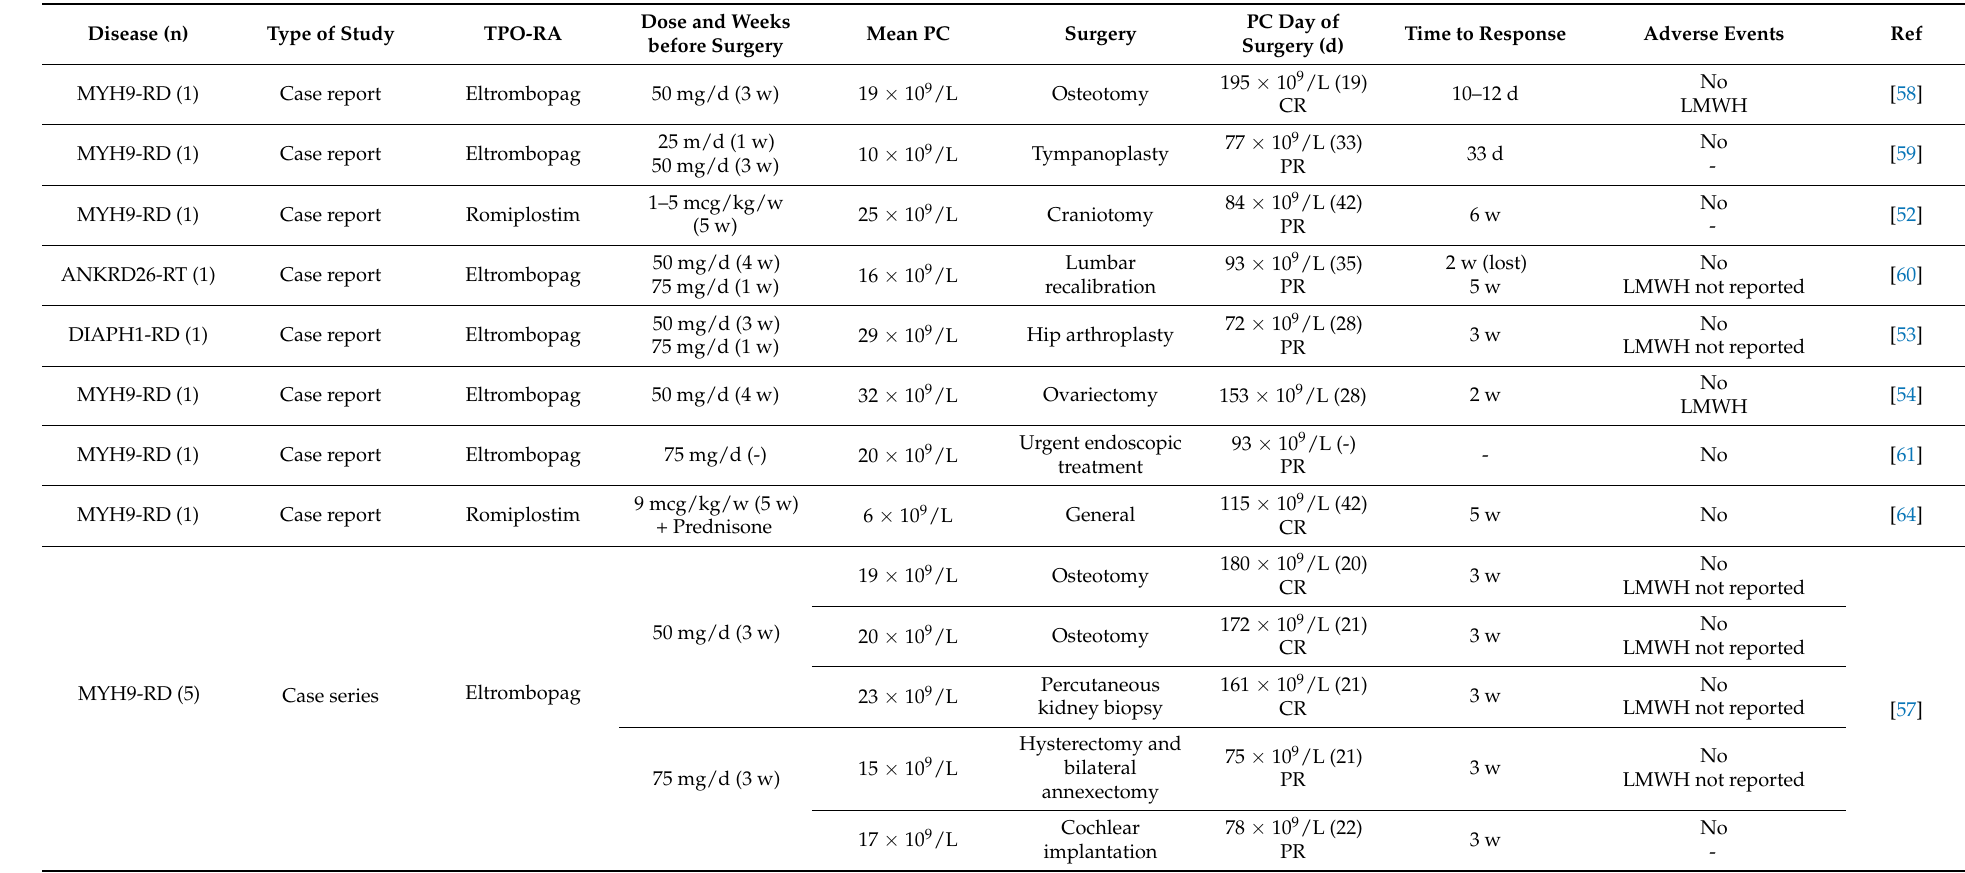
Table 3. Previous experience with the use of TPO-RA to prepare patients with inherited thrombocytopenia for elective surgeries and/or invasive